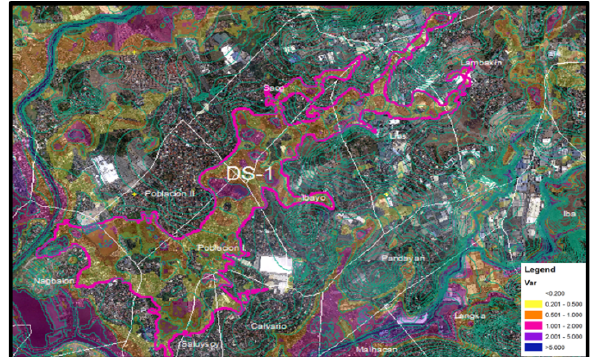
Figure 15. Depression Storage DS-1